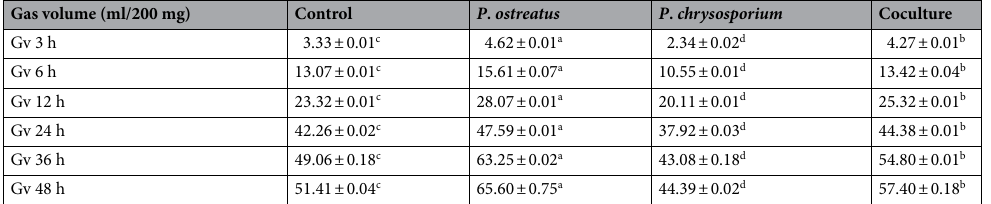
Table 3. In vitro gas volume from rice straw after incubation with axenic and coculture white-rot fungi. All values are mean ± standard error. Gv, Gas volume. a–d Values with different superscript letters in a row represent significant difference ( P <